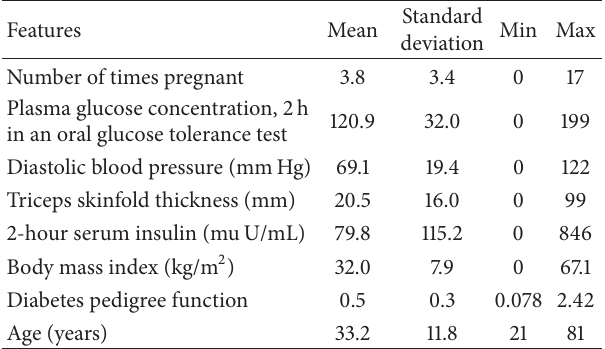
Table 4: Features and parameters of the diabetes dataset.